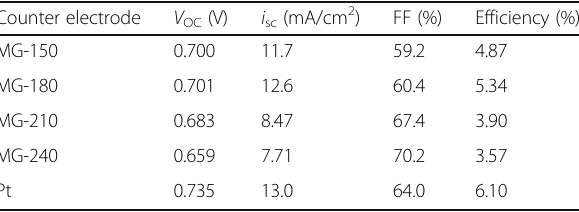
Table 1 DSSC performance data comparison Counter